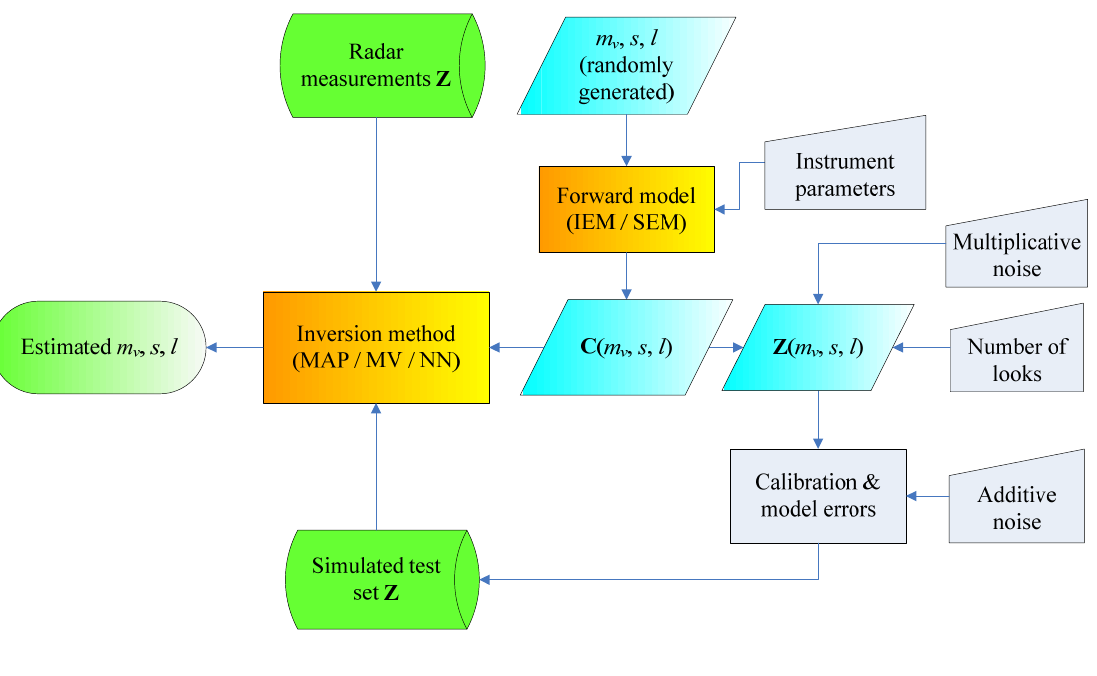
Figure 1 . Logical scheme of the procedure adopted in this